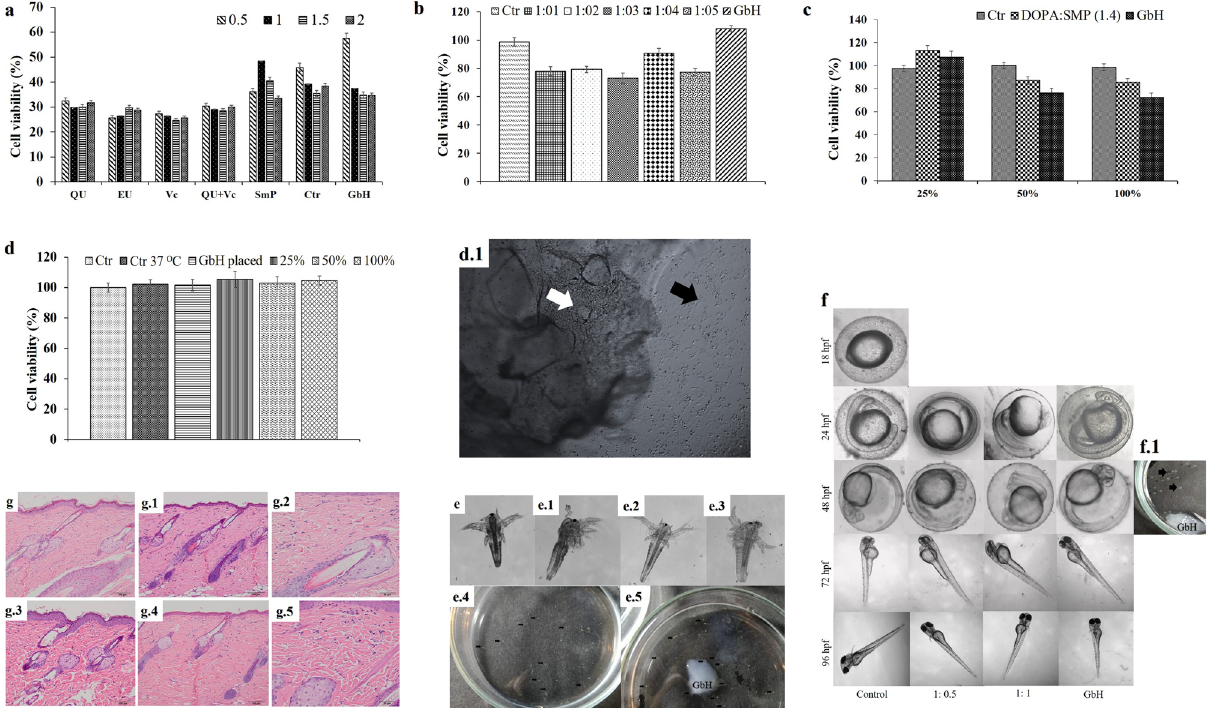
Figure 4. In vitro and in vivo performance of GbH as a dressing material for second-degree burn wounds: Cytotoxicity assessment of the GbH using L929 cells: ( a ) Cell viability of L929 when exposed to GbH for 24 h, where Hb is hydrogel base with no stabilizer and the legend denotes the concentration (mg) of each test stabilizer; ( b ) Cell viability of 3T6 when exposed to the GbH leachate medium for 24 h, where Ctr is the GbH base with no stabilizer and the legend denotes the ratio of polydopamine to sodium metaperiodate and ( c ) Cell viability of 3T6 when exposed to the GbH leachate media for 24 h at a different percentage, where Ctr is the GbH base with no stabilizer and the legend of the ratio denotes polydopamine and sodium metaperiodate ratio in the GbH. ( d ) Cell viability of the HaCat when the GbH is in contact with the cells (GbH placed) and leachate medium at 100% medium replacement incubated for 24 h, where Ctr denotes control, Ctr 37 °C denotes the positive control; ( d.1 ) Observed event of healthy HaCat cells after 24 h in contact with the GbH, where white arrow denotes the GbH and black arrow denotes healthy HaCat cells in 96-well plate. Observed development of brine shrimp when exposed to the GbH for 24 h, ( e ) Positive control: nauplii from the aerated tank; ( e.1 ) Control: nauplii in artificial saltwater; ( e.2 ) and ( e.4 ) Test: nauplii in 1:1 medium of the GbH leeched buffer and artificial saltwater; ( e.3 ) and ( e.5 ) Test: The GbH placed in brine shrimp in an artificial saltwater medium. Short–term toxicity test on embryo and sac-fry stages of zebrafish model: ( f ) Observed development of zebrafish when exposed to the GbH (GbH direct contact and 1:1 medium, i.e., the GbH leeched buffer and E3 medium) for 18–96 hpf; ( f.1 ) Observed healthy zebrafish eggs at 48 hpf in contact with the GbH. Photomicrographs showing the histopathology of the skin in rats. Normal appearances of the epithelium in the male ( g ) and female ( g.1 ) rats of the control group. Minimal acanthosis of the male ( g.3 ) and female ( g.4 ) rats. Normal dermis appearance in the control rat ( g.2 ) and minimal inflammatory cell infiltration in the treated ( g.5 )